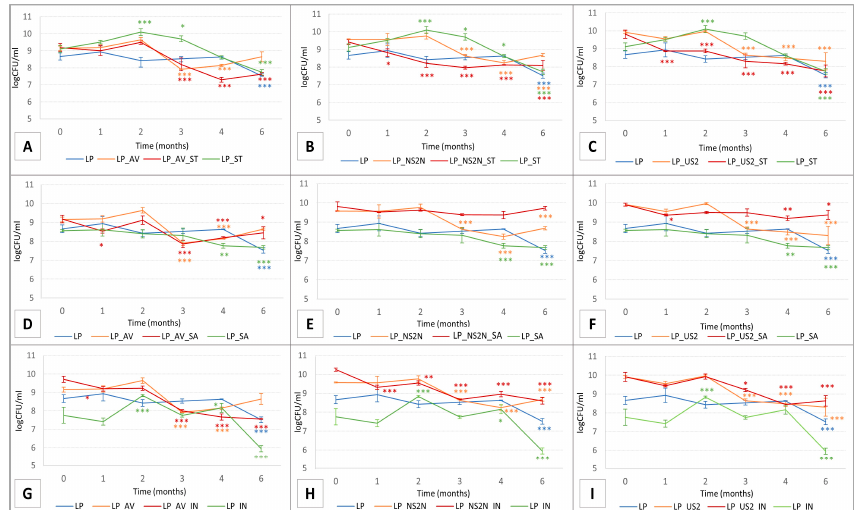
Figure 3. Comparison of viability plots of lyophilized samples containing Lactobacillus plantarum R2 Biocenol™ in di ff erent composition combinations of constitutional excipients and cryoprotect- ants : starch ® 1500 with: ( A ) Avicel ® PH-101, ( B ) Neusilin ® NS2N, and ( C ) Neusilin ® US2; saccharose with: ( D ) Avicel ® PH-101, ( E ) Neusilin ® NS2N, and ( F ) Neusilin ® US2; inulin with: ( G ) Avicel ® PH- 101, ( H ) Neusilin ® NS2N, and ( I ) Neusilin ® US2. Statistical signi fi cance from two-way ANOVA test with additional Dunne tt ’s multiple comparison tests is marked with a color resolution for each curve as follows: *** p < 0.001; ** p < 0.01; * p < 0.05, respectively.